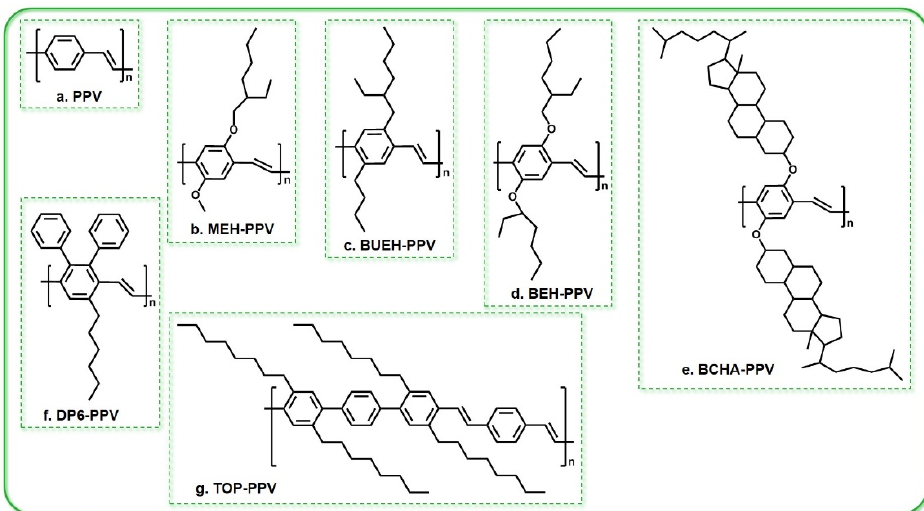
Figure 7. The chemical structures of some PPV derivatives. ( a ) PPV: poly(phenylenevinylene); ( b )